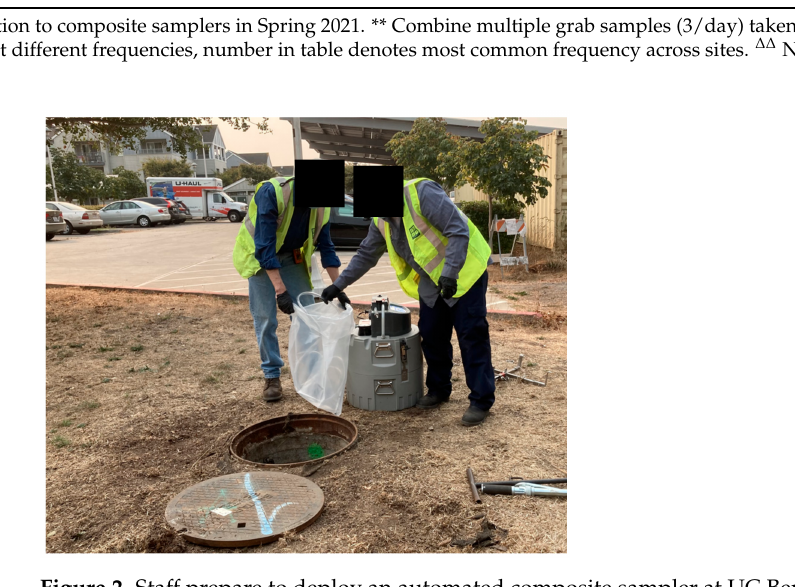
Figure 2. Staff prepare to deploy an automated composite sampler at UC Berkeley. Colleges used student workers, existing staff, or private contractors to collect samples and deliver or ship them to laboratories for analysis. Retrieving samples from collection points took from 15 min to 3 h per sample (not including the 24 h over which compos- ite samples are collected) depending on the physical layout of sampling locations and